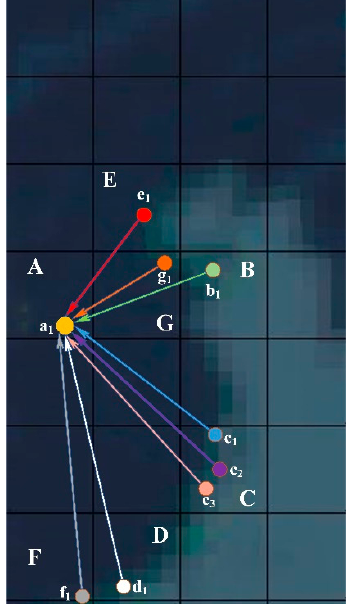
Figure 10. Traceability analysis graph of unqualified products.